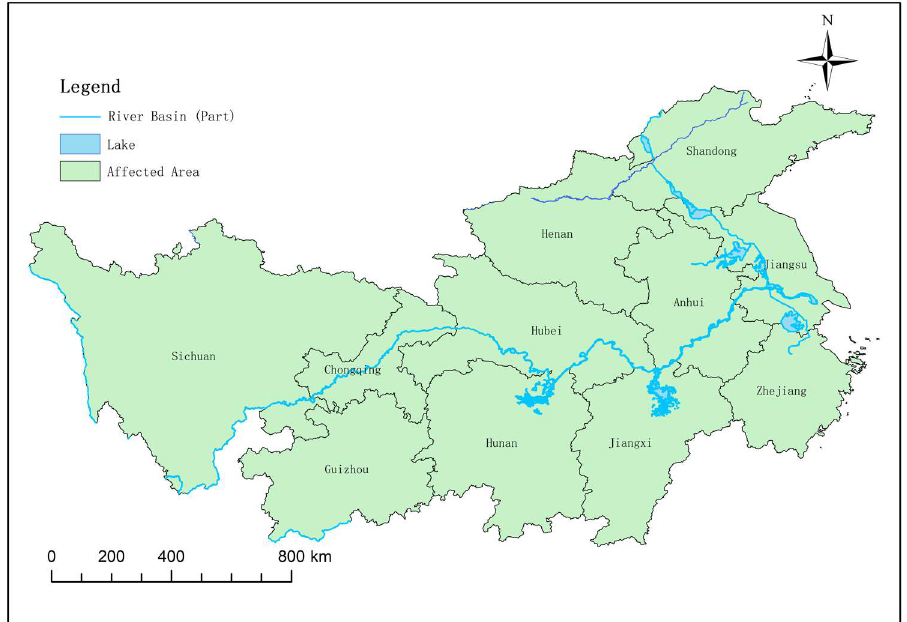
Figure 13. Study Figure 13. Study area.